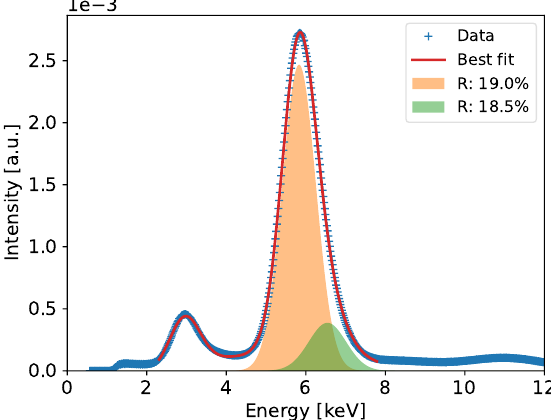
Figure 6. GEM detector A 2 . 55 Fe spectrum for detector bias voltage of